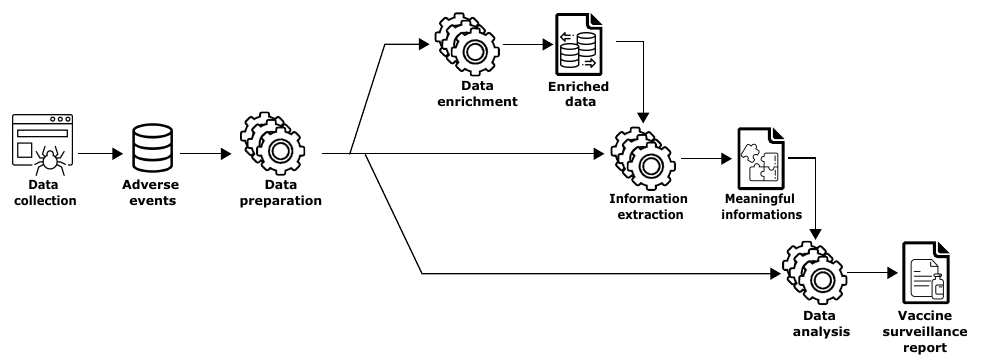
Figure 1. Workflow of the proposed